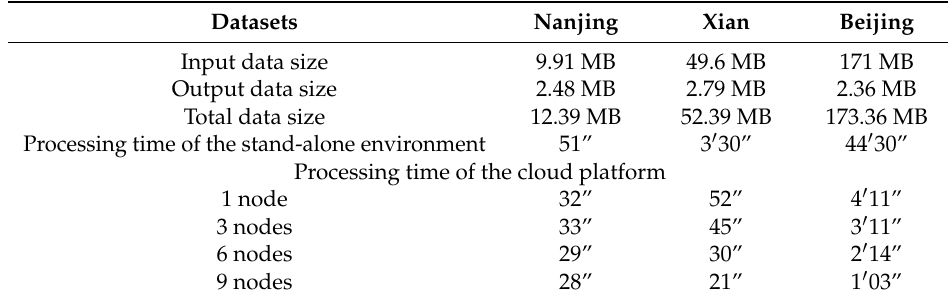
Table 3. The run time of point generalization in the environment using generalization without suggested constraints and in the environment using generalization with suggested constraints.